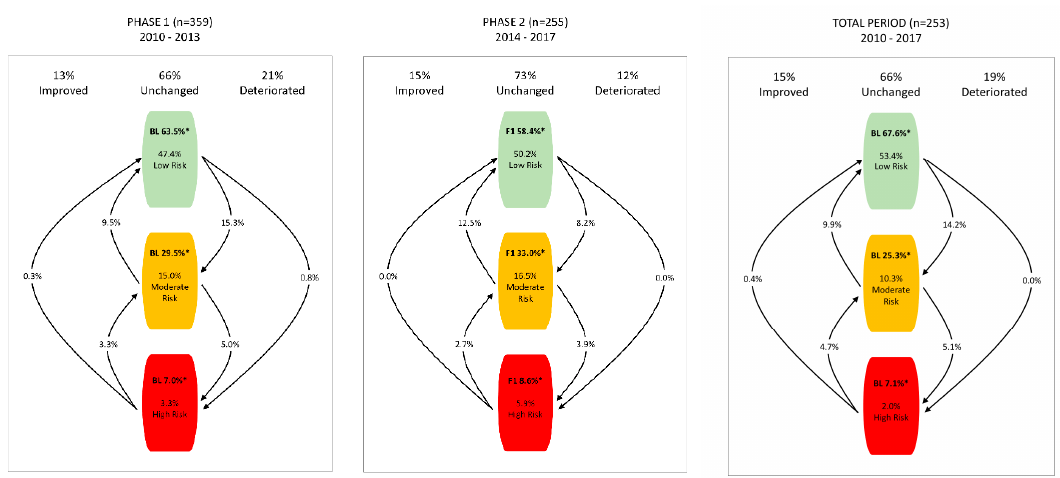
Figure 1. Overall Health Risk Level Transitions During Phase 1, Phase 2 and Total period; * The proportion of low-, moderate- and high-risk participants at the starting point of each